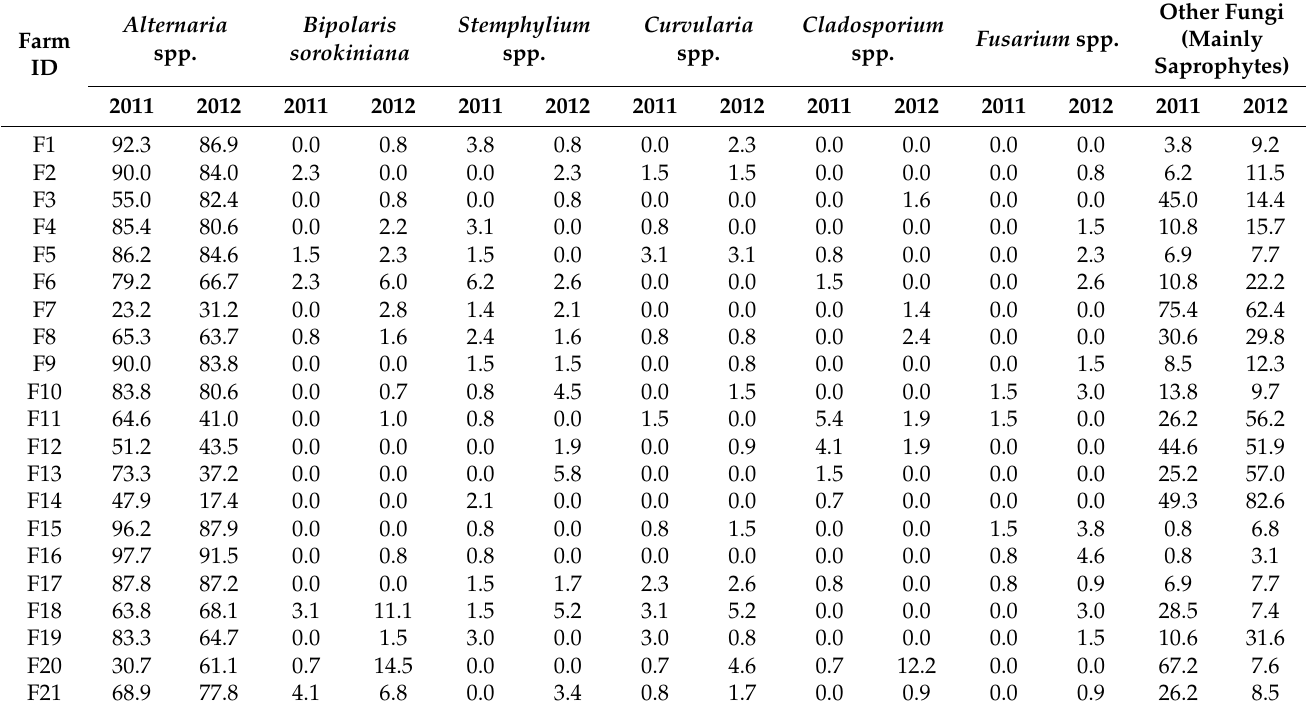
Table 3. Prevalence of major fungi (expressed as %, frequency of infection) identified in grain samples from the farms surveyed. Alternaria Farm spp. ID F1